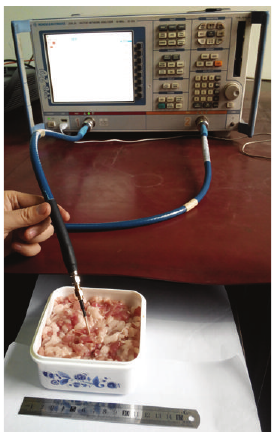
Figure 8: Photograph of the measurement setup.